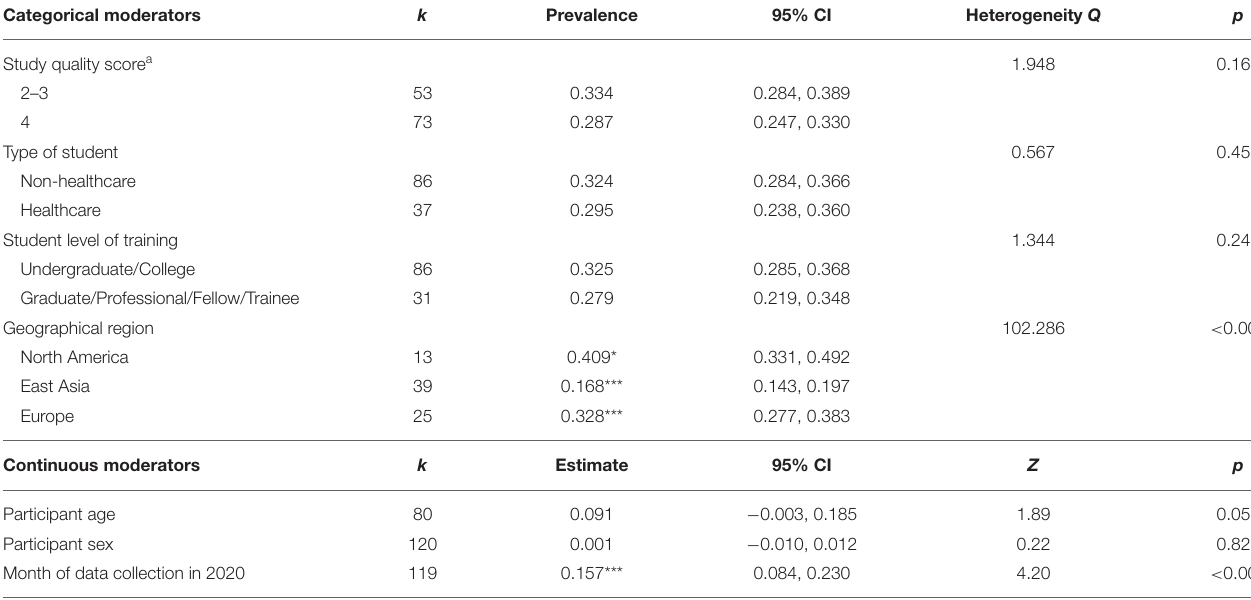
TABLE 2 | Results of moderator analyses for the prevalence of depressive symptoms in post-secondary students during COVID-19. Categorical